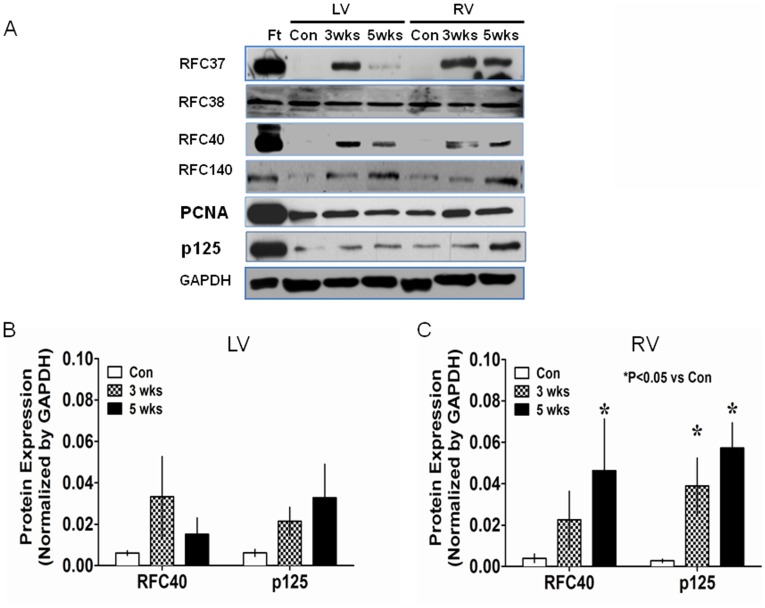
DNA replication proteins are re-expressed in hypertrophied RV.Total protein lysates (50 µg) obtained from LV and RV tissues (n = 5) of the control (Con), SUHx-3 wks (3 wks) and SUHxNx-5 wks (5 wks) were analyzed by 12% or 9% SDS-polyacrylamide gels. (A) Expression of RFC37, RFC38, RFC40, RFC140, PCNA and p125 proteins was determined by Western blot analyses. Whole hearts isolated from 15 day-old fetus (n = 5) were used as a positive control (Ft). GAPDH was used as the loading control. (B and C) Graphs represent summary data for the protein expression of RFC40 and p125 proteins in LV (B) and RV (C) normalized by GAPDH (n = 5). Values are mean ± SE. *indicates P<0.05 vs. control.[/LOOSEST]